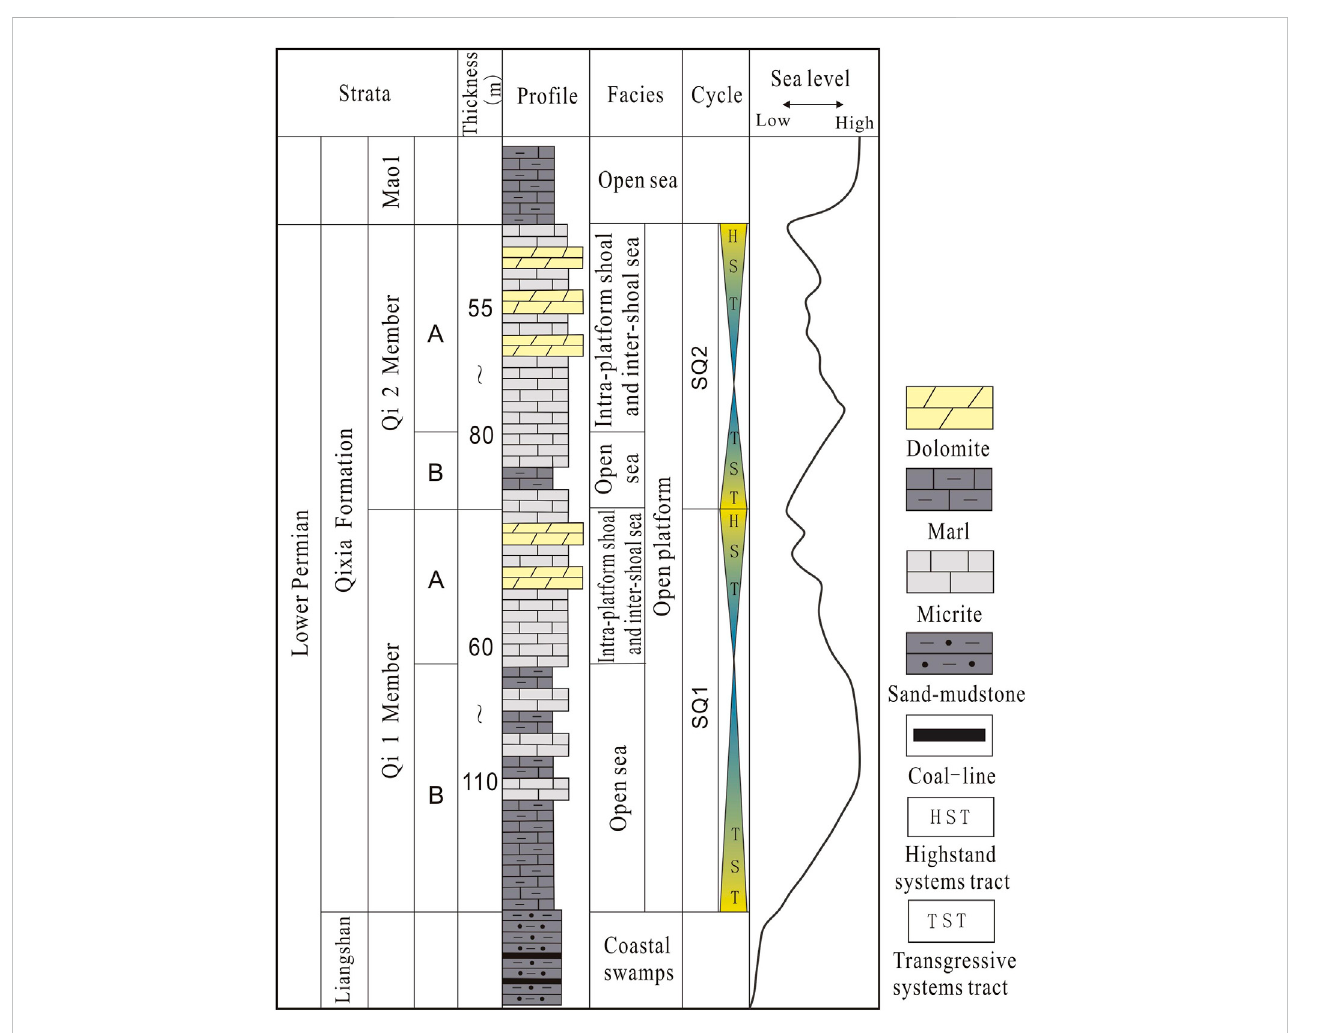
FIGURE 2 Stratigraphic integrated histogram of Qixia Formation in the study